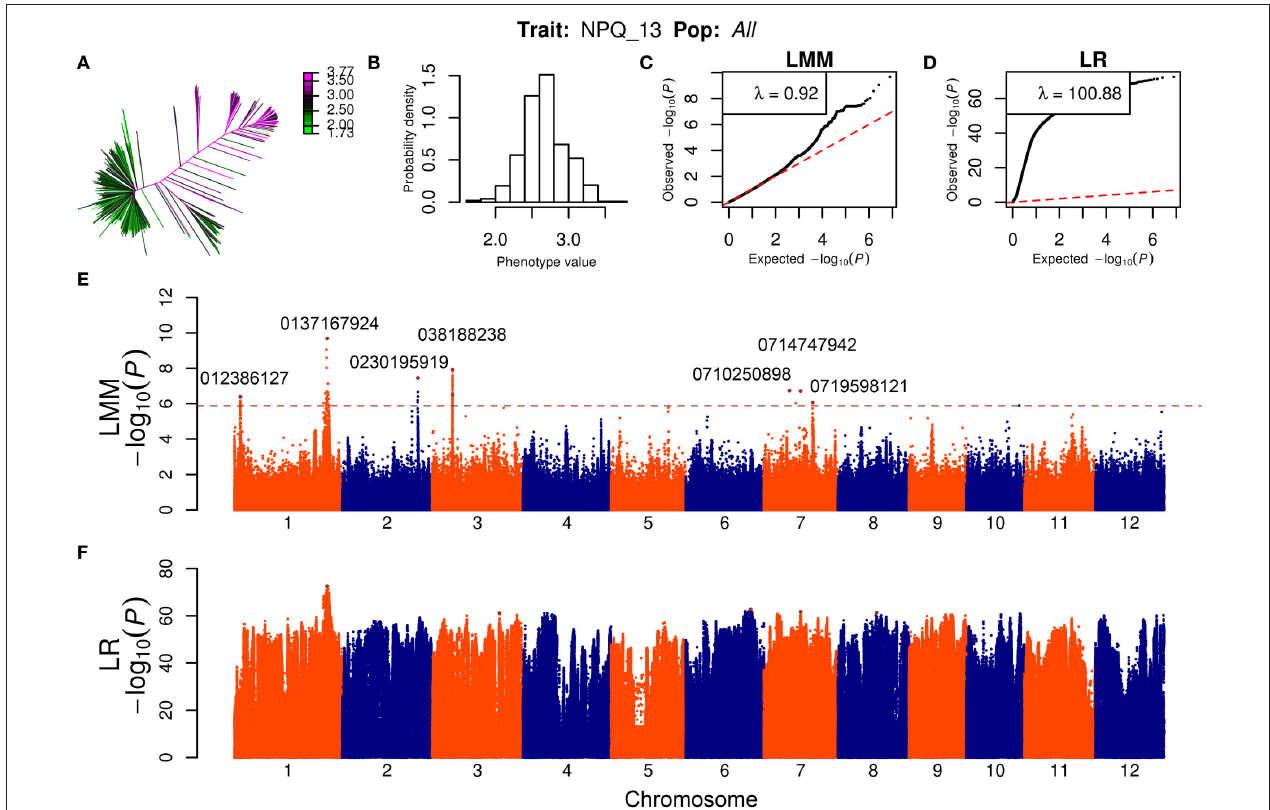
FIGURE 1 | GWAS of NPQ values in 2013 for the whole association population. (A,B) The heatmap (A) and histogram (B) distribution of NPQ values in 2013 in 529 accessions. (C,D) Q-Q plot of the expected null distribution and the observed P -value using the linear mixed model (LMM) (C) and the simple linear regression (LR) model (D) . (E,F) Genome-wide P -values for the LMM (E) and simple LR model (F) . The horizontal dashed line indicates the significance thresholds set as P = 1.32 × 10 − 6 for the whole population by LMM. The SNP positions of representative peak signals in LMM were denoted.